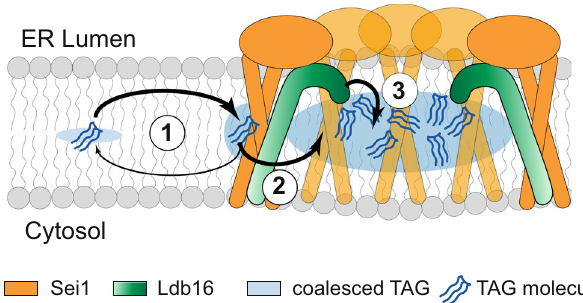
Fig. 6 A model for LD formation by the Sei1-Ldb16 complex. Sequential TAG interactions mediate LD assembly by the Sei1-Ldb16 complex. In the ER bilayer, TAG molecules (blue) concentrate in proximity of Seipin oligomers (orange) via weak interaction with Sei1 TMs. TAG molecules within the ring interact strongly with Ldb16 (green) hydroxyl-containing residues, facilitating TAG coalescence and lens formation (see text for